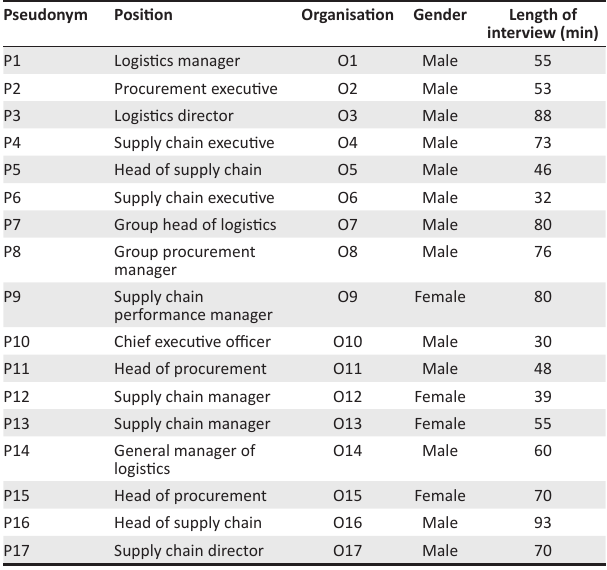
TABLE 1: Participants’